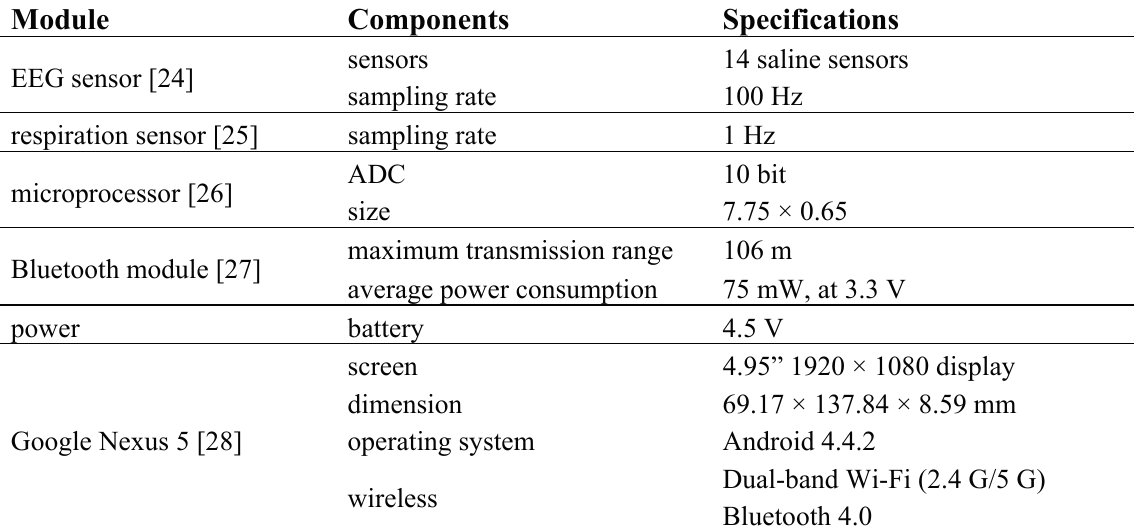
Table 1. Specifications of the sensor module that consists of an EEG sensor, a respiratory sensor, a microprocessor, and a Bluetooth